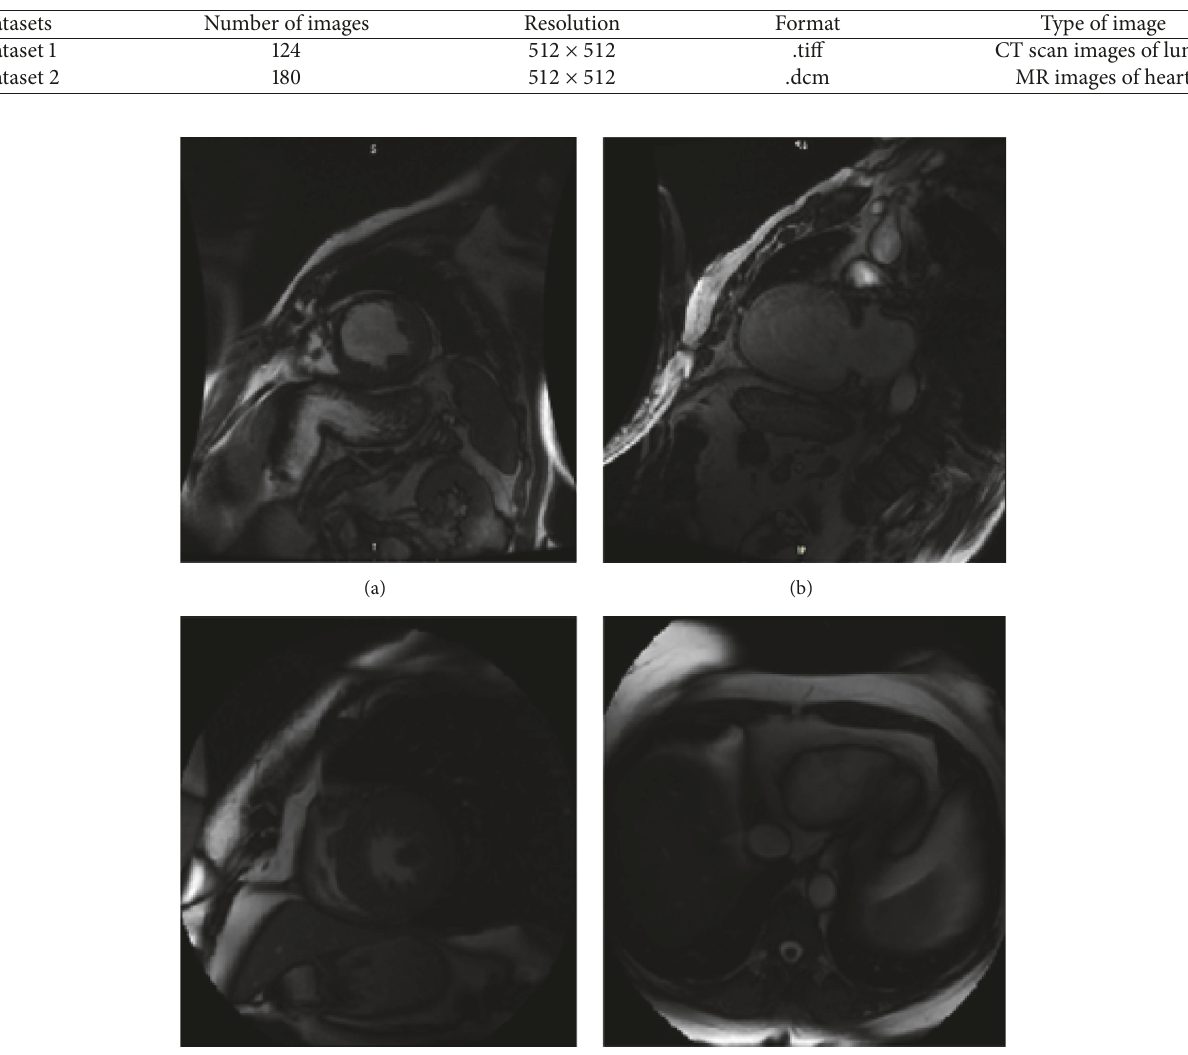
Table 1: Configuration of datasets used for experimentation.